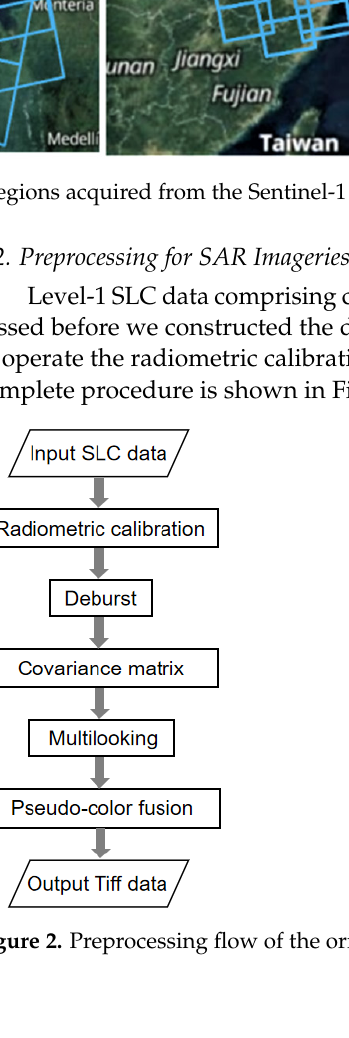
Figure 2. Preprocessing flow of the original Sentinel-1 imagery.